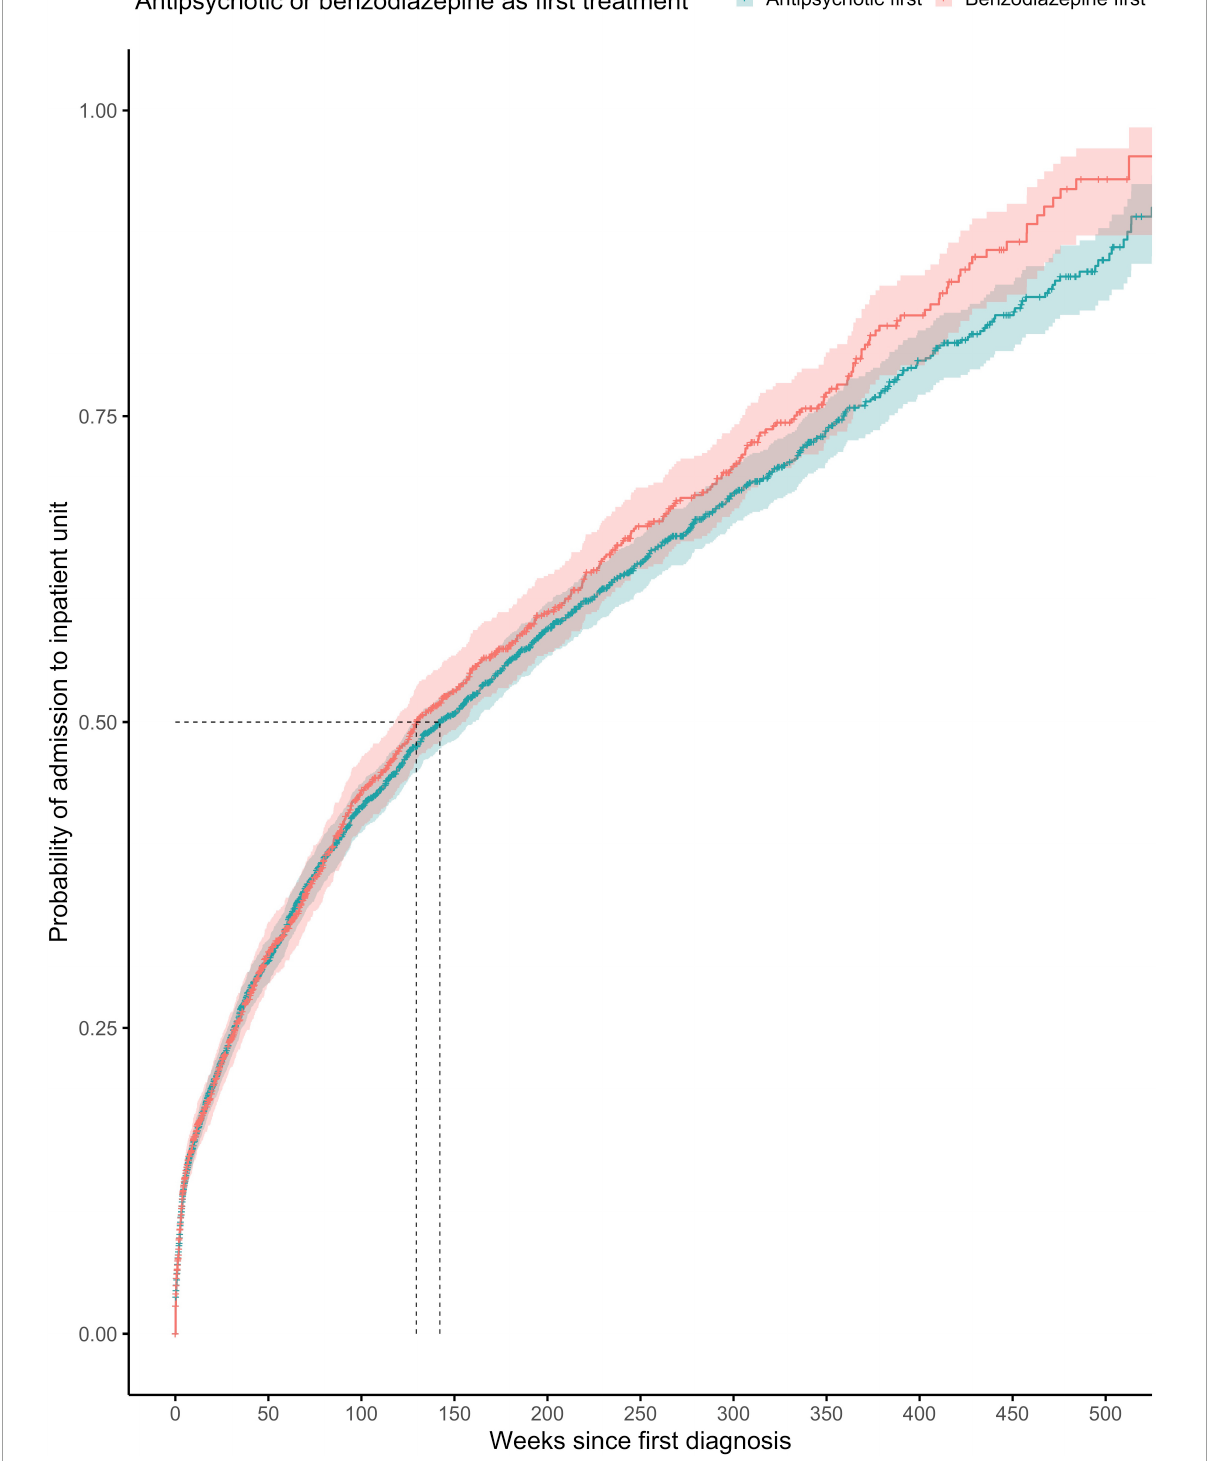
FIGURE3 Kaplan-Meier survival curve showing cumulative probability of any psychiatric admission over time (weeks) after FEP diagnosis for patients prescribed with antipsychotics or benzodiazepine as first treatment (at any point). Greenwood 95% confidence intervals are displayed for each curve. The dashed lines indicate the median time to admission in each